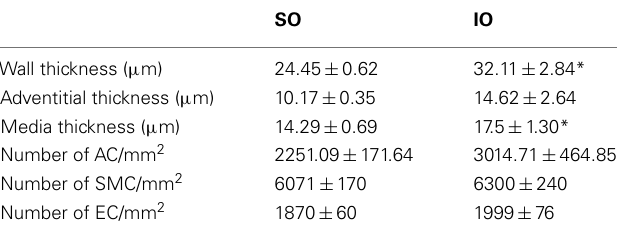
Table 1 | Comparison of morphological parameters in pressurized segments of mesenteric resistance artery from SO and IO rats